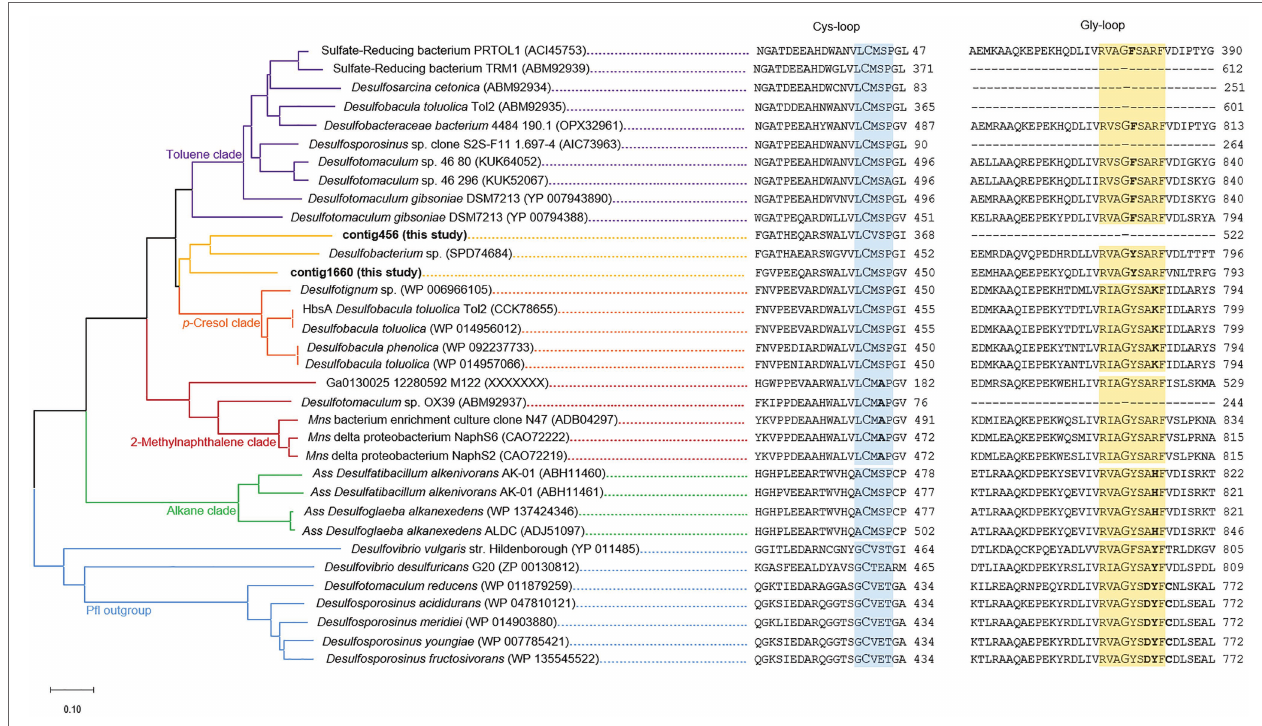
FIGURE 2 | Phylogenetic tree based on the partial bssA-like amino acid sequences from a BTEX biodegradation assay (in bold; this study) compared with the fumarate-adding enzyme (FAE) sequences available in international databases. The evolutionary history was inferred using the neighbor-joining method (Saitou and Nei, 1987). The optimal tree with the sum of branch length = 6.67348502 is shown. The tree is drawn to scale, with branch lengths in the same units as the evolutionary distances used to infer the phylogenetic tree. The evolutionary distances were computed using the Poisson correction method (Zuckerkandl and Pauling, 1965) and are presented in units of the number of amino acid substitutions per site. This analysis involved 34 amino acid sequences. All ambiguous positions were removed from each sequence pair (pairwise deletion option). There were a total of 914 positions in the final dataset. Evolutionary analyses were conducted in MEGA X (Kumar et al.,